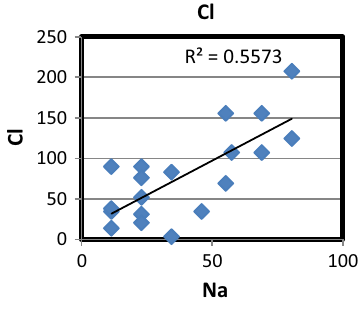
Fig. 2 Correlation of Na versus Cl